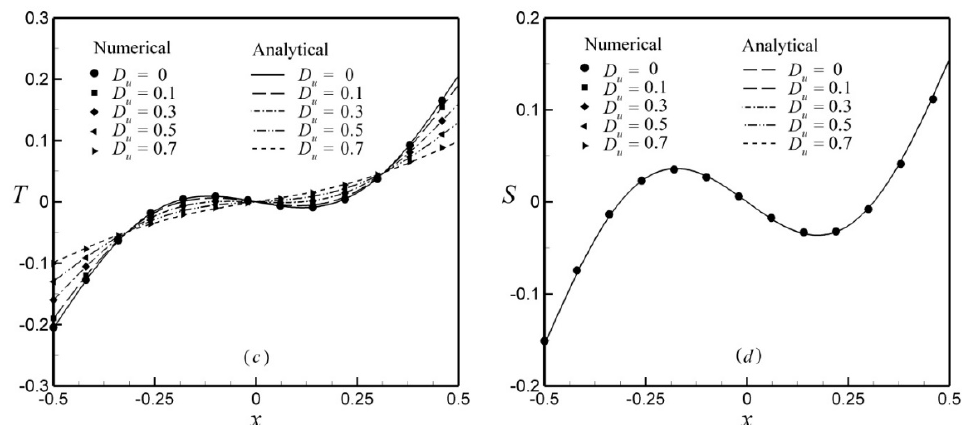
Figure 7. Stream function ( a ), velocity ( b ), temperature ( c ), and concentration ( d ) profiles in x - direction at mid-height of the enclosure for A = 10, Da e = 1, Le = 10, R T = 10 4 , ξ = 0, ε = 1, S r = 0 and various values of D u